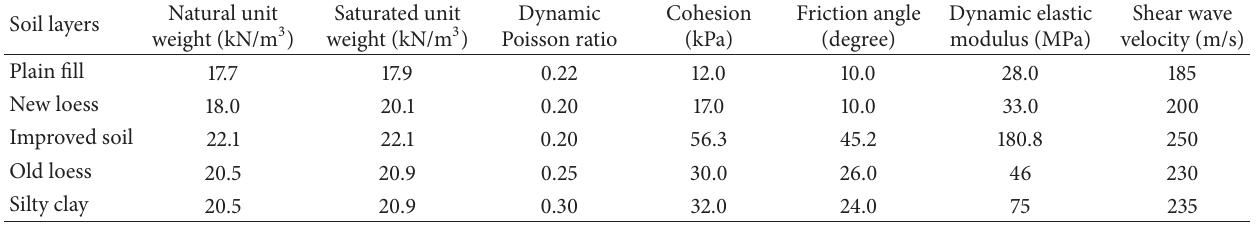
Table 1: Properties of soil layers [32].